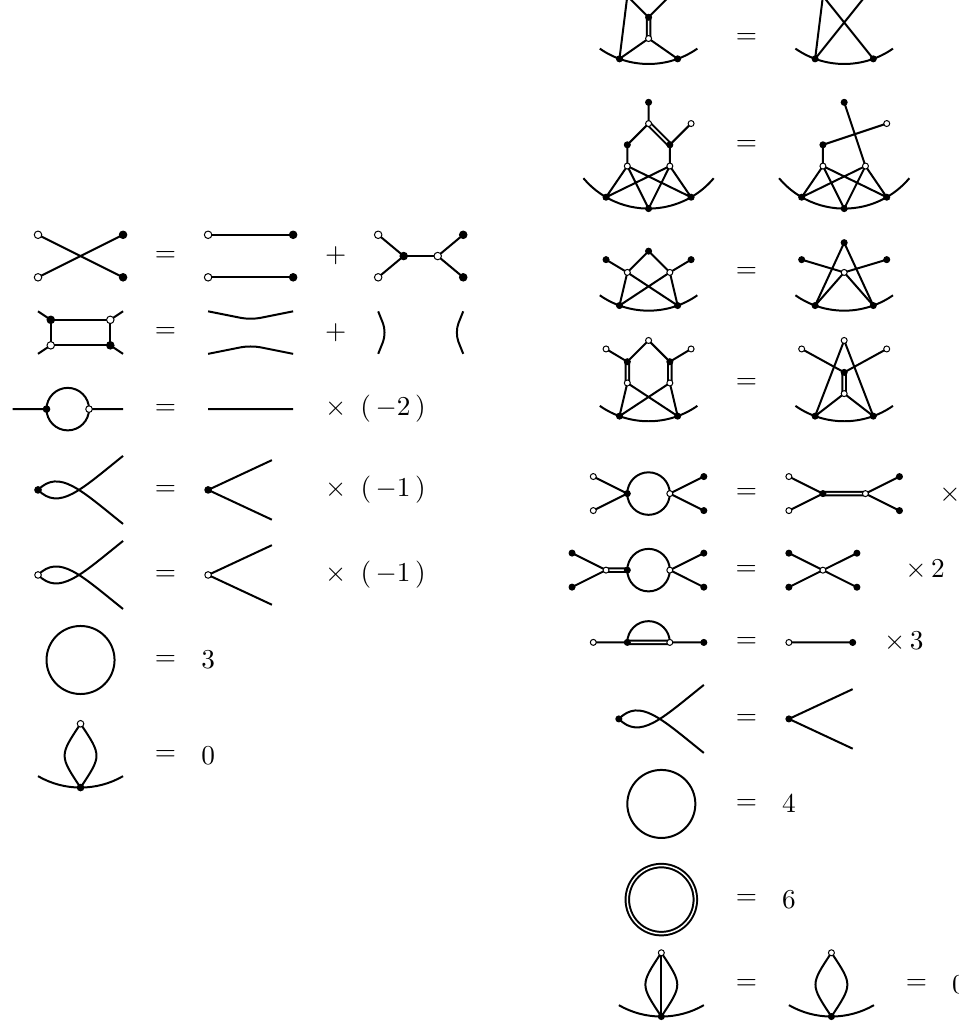
Figure 5. The skein relations for sl 3 and sl 4 tensor diagrams, adapted from [23, 40]. As mentioned in the text, the latter graphical relations are equivalences from skein relations between tensor invariants mod overall sign. Additionally, the sl 4 relations in the sixth and eighth lines hold with all colors exchanged. These relations are all derivable from identities for contractions of Levi-Civita tensors; for example the top relation on the left shows δ d